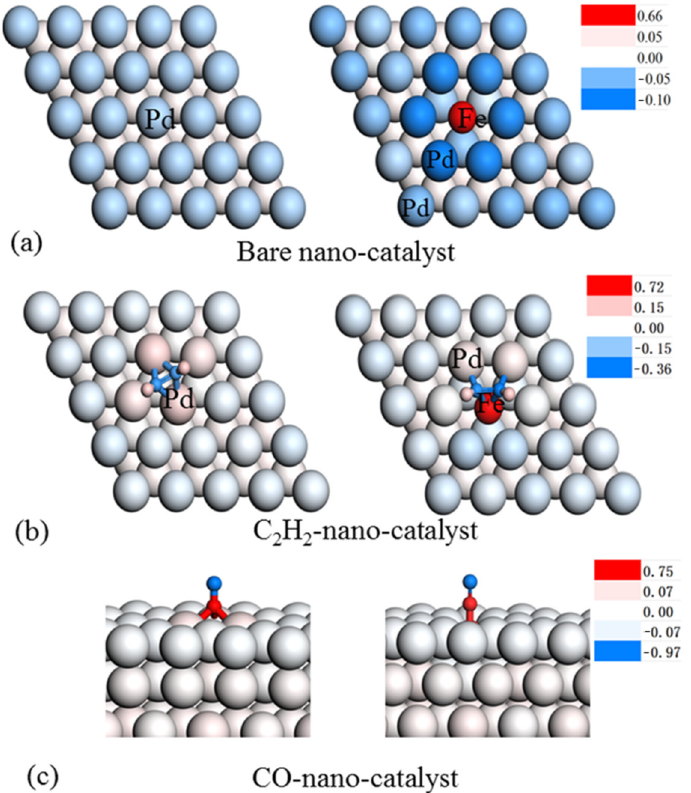
Figure 14. Bader charge analysis of bare nano-catalysts ( a ), C 2 H 2 adsorbed on the nano-catalyst surface ( b ) and CO adsorbed on the nano-catalyst surface ( c ). The colors indicate the Bader charge of each atom. The profile of each atom is shown on the right.